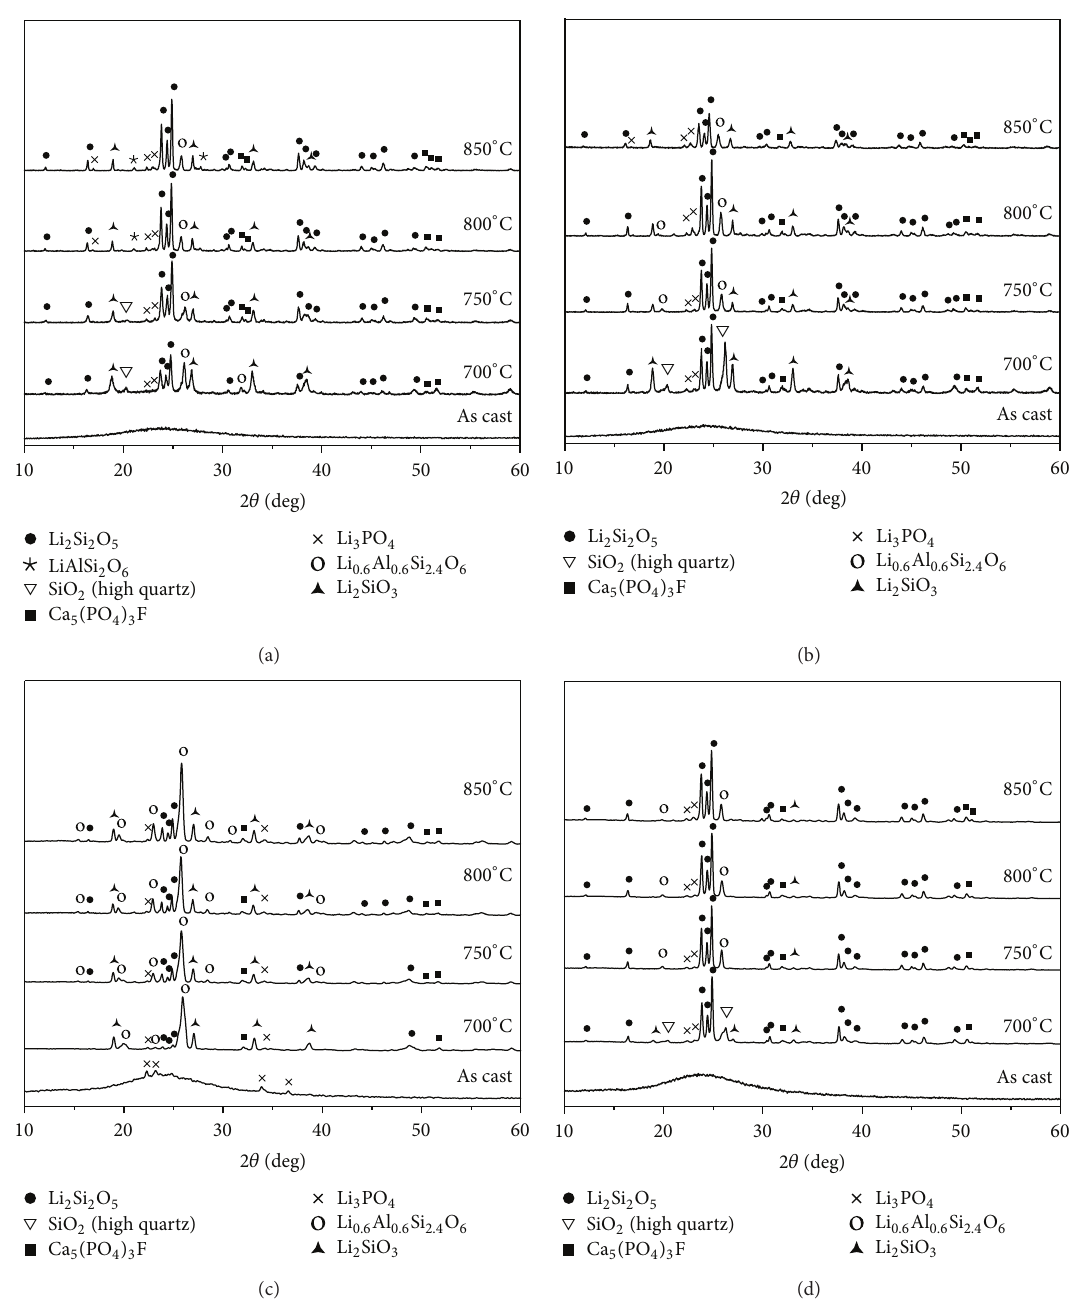
Figure 4: X-ray diffraction patterns of (a) LD1, (b) LD2, (c) LD3, and (d) LD4 after heat treatment at 700–850 ∘ C for 2hrs.